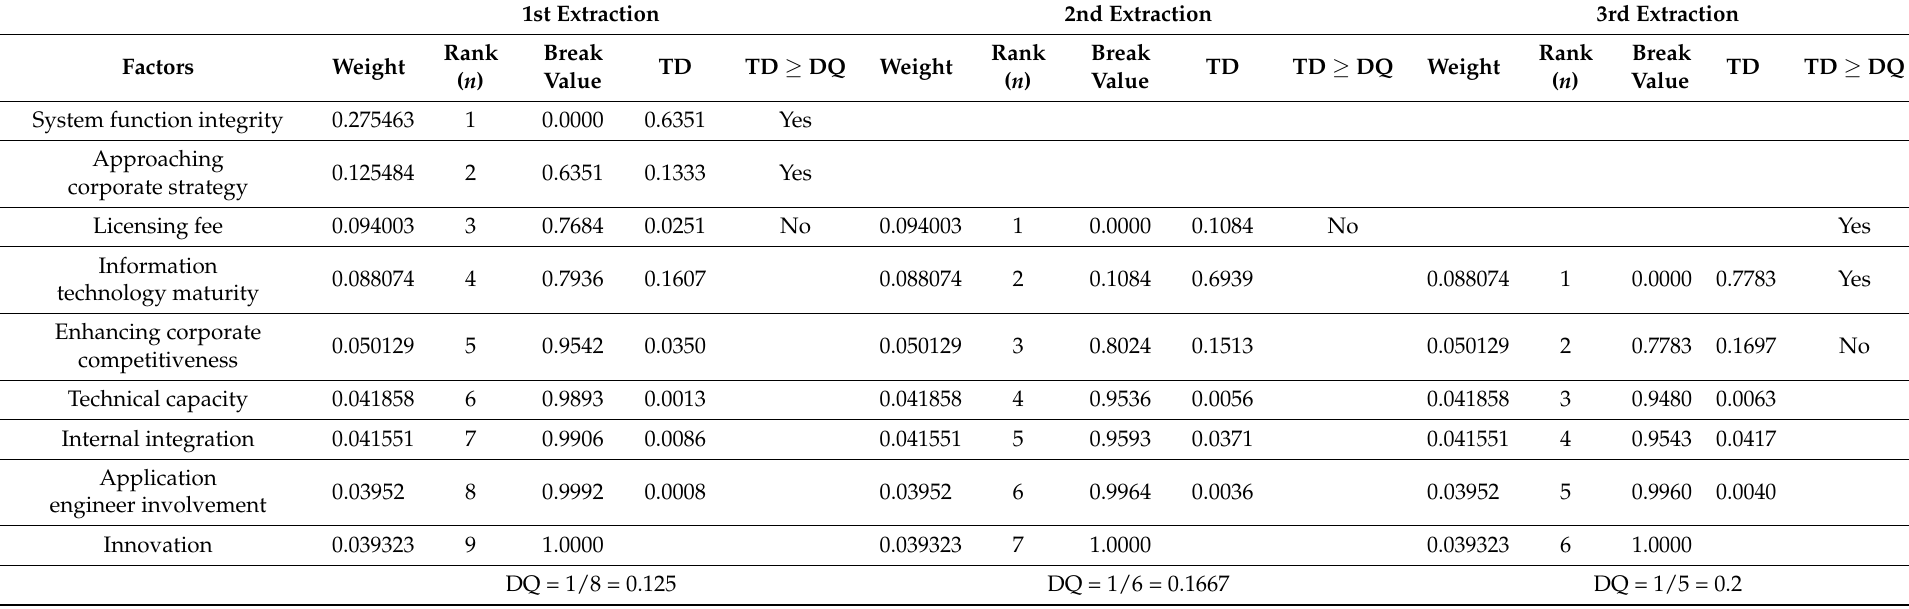
Table 5. CFs’ extraction for influencing MRs in introducing MP